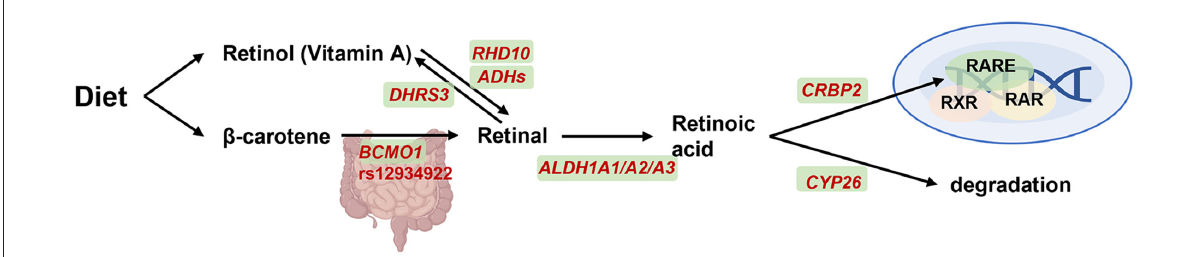
FIGURE3 BCMO1 on transport, signaling and degradation of vitamin A metabolism. Retinol from diet is transported throughout the vasculature and oxidized by retinol dehydrogenase 10 (encoded by RHD10 ) and alcohol dehydrogenases (encoded by ADHs ) into retinal and then oxidized into retinoic acid (RA) by aldehyde dehydrogenase 1A1, A2, and A3 (encoded by ALDH1A1-3 ). Retinal was also reversible generation to vitamin A by short-chain dehydrogenase/reductase (encoded by DHRS3 ). β -carotene was another alternative pathway which conversed to retinal by β -carotene-15,15-dioxygenase (encoded by BCMO1 ). Subsequently, on one hand, RA will be combined with binding to cellular retinol binding protein 2 (CRBP2) and then activate gene expression together with retinoid-X-receptor (RXR), retinoic acid receptor (RAR) and retinoic acid receptor element (RARE). On another hand, RA can diffuse from cell and degraded by cytochrome P450 26A1 (CYP26) enzyme. Created with